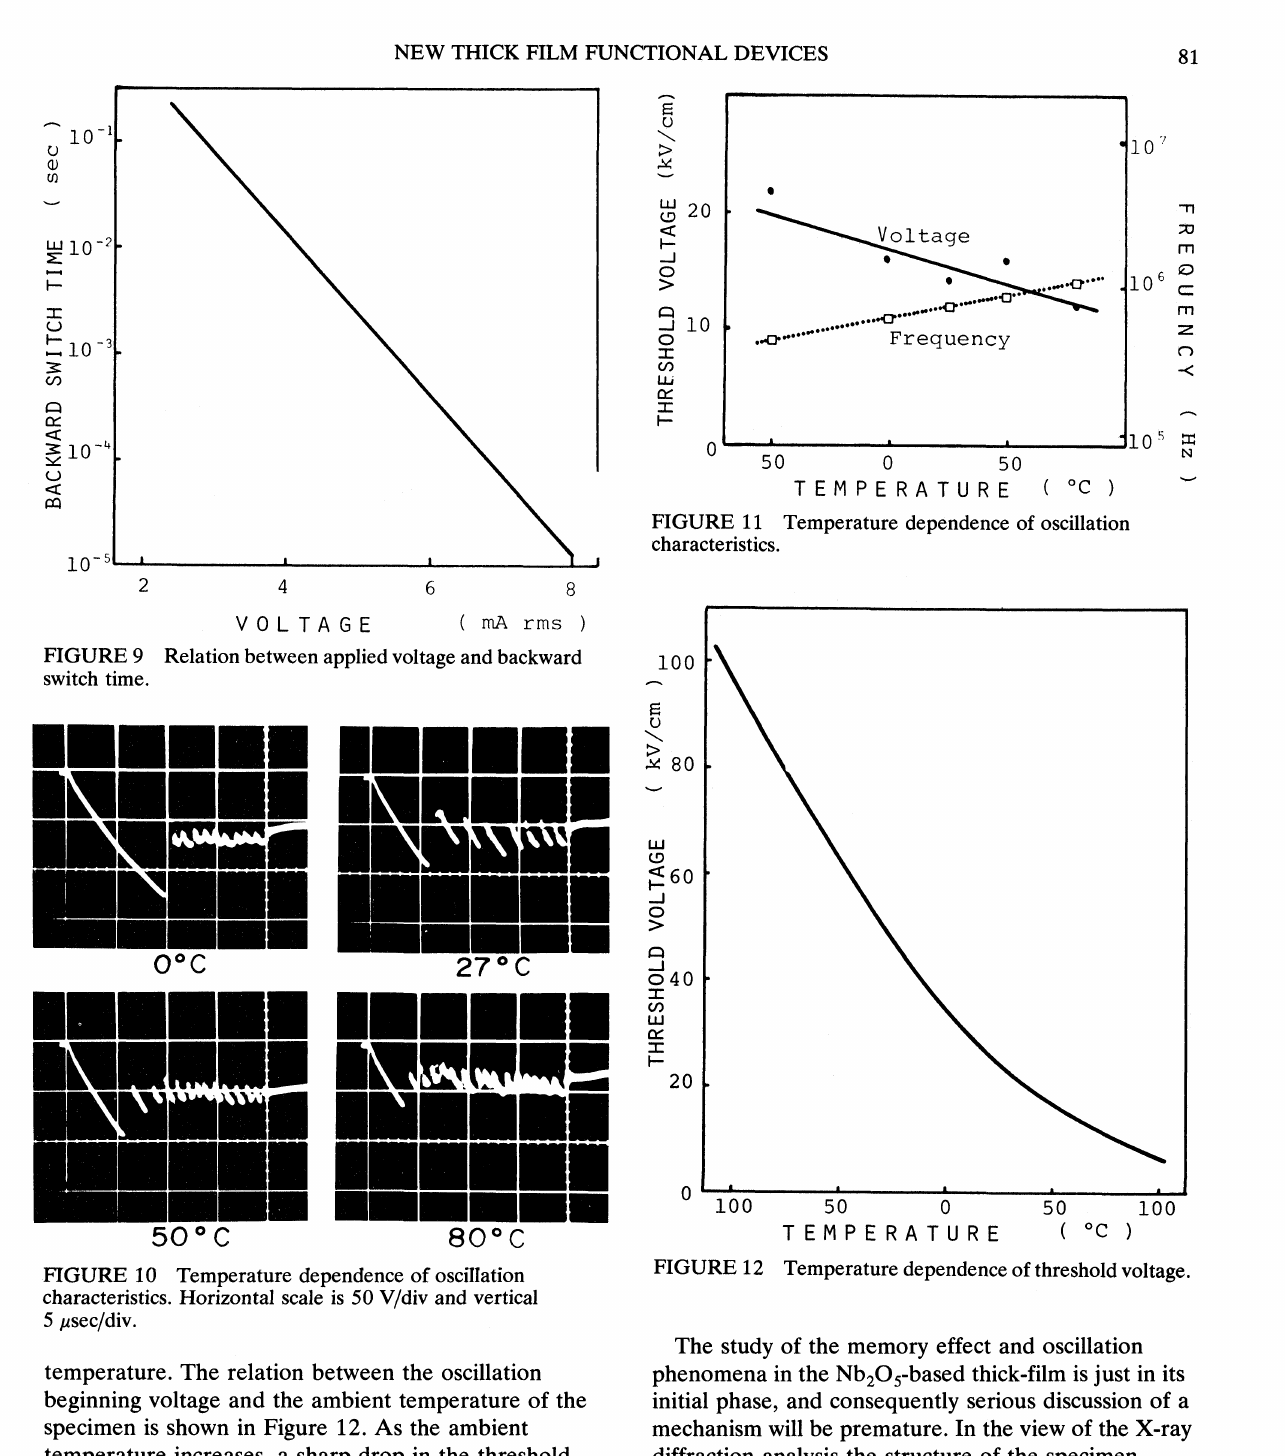
FIGURE I0 Temperature dependence of osciIIation characteristics. Horizontal scale is 50 V/div and vertical 5 psec/div.